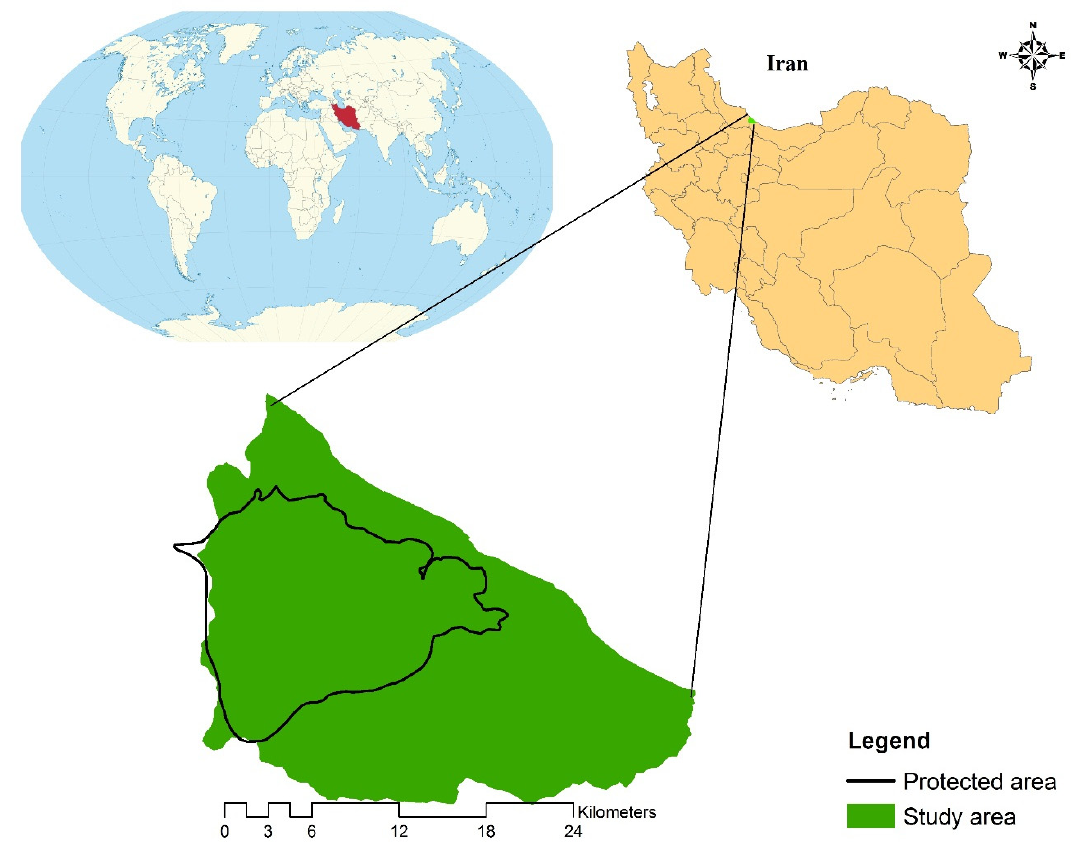
Figure 1. Geographic location of the Sarvelat and Javaherdasht district and the World Heritage Hyrcanian (Caspian) forests area.